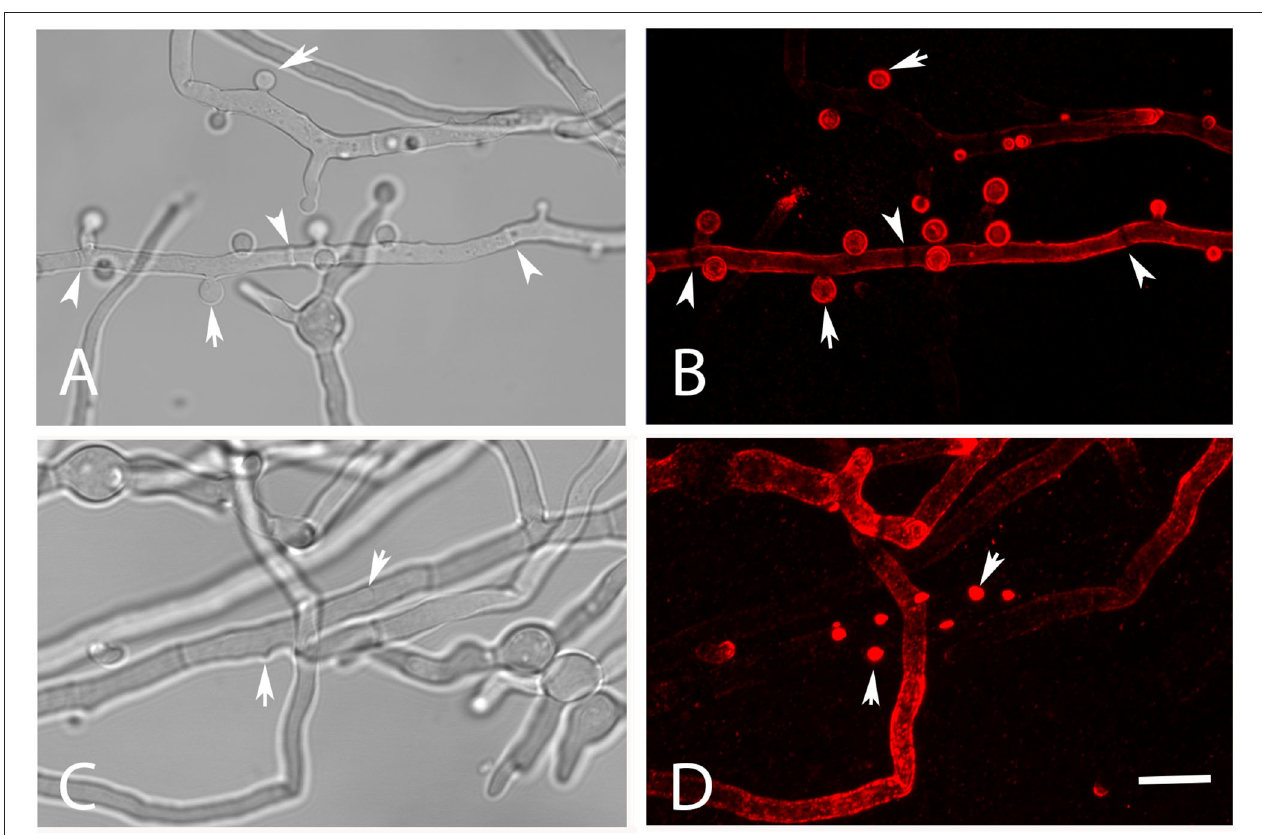
FIGURE 2 | Detection of galactomannan on hyphae of strain At17-14 grown in AMM at 37 ◦ C. The staining with the galactomannan-specific antibody L10-1 is shown in red. Mature AC are indicated by arrows in (A,B) . Nascent AC are indicated by arrows in (C,D) . Arrowheads point to the positions of septa in (A,B) . The bar in (D) represents 10 µ m and is valid for all